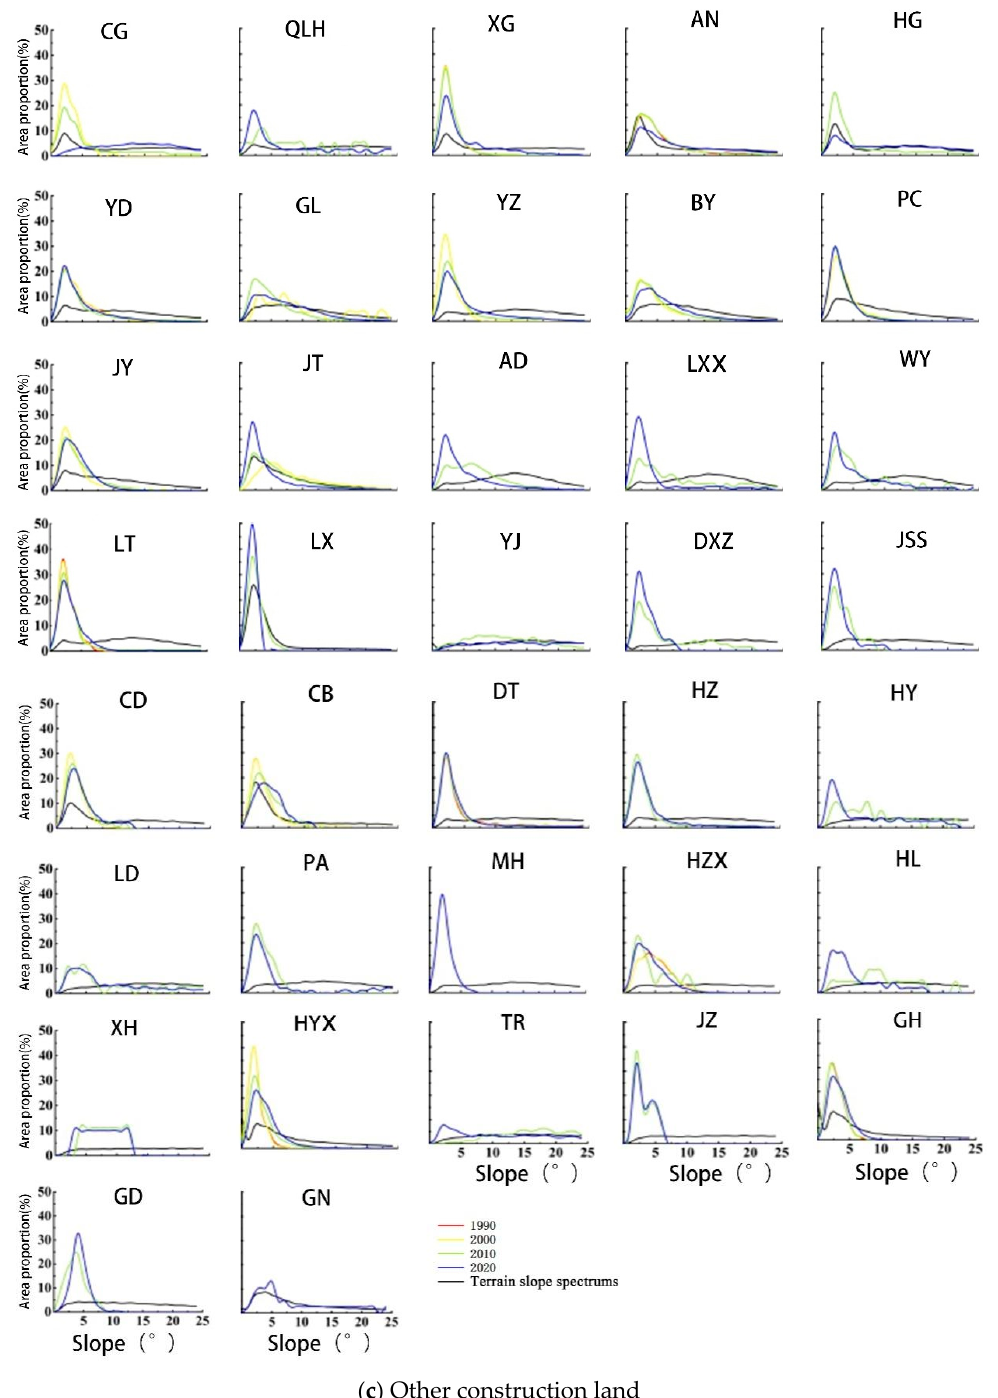
Figure 15. Terrain and built-up land slope spectra of counties (districts) in the LXUA from 1990 to